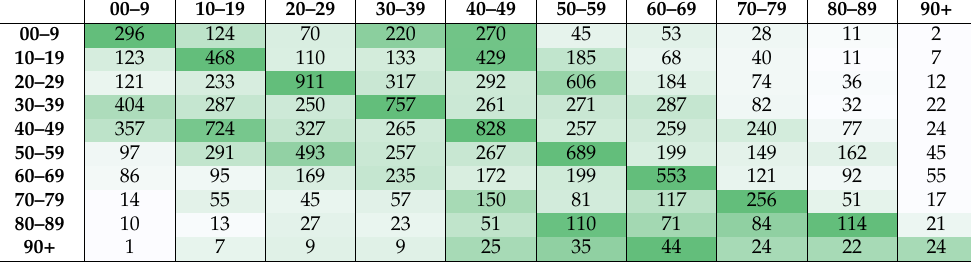
Table 1. Contact matrix regarding the data of the different age groups between 2020 and 2021.